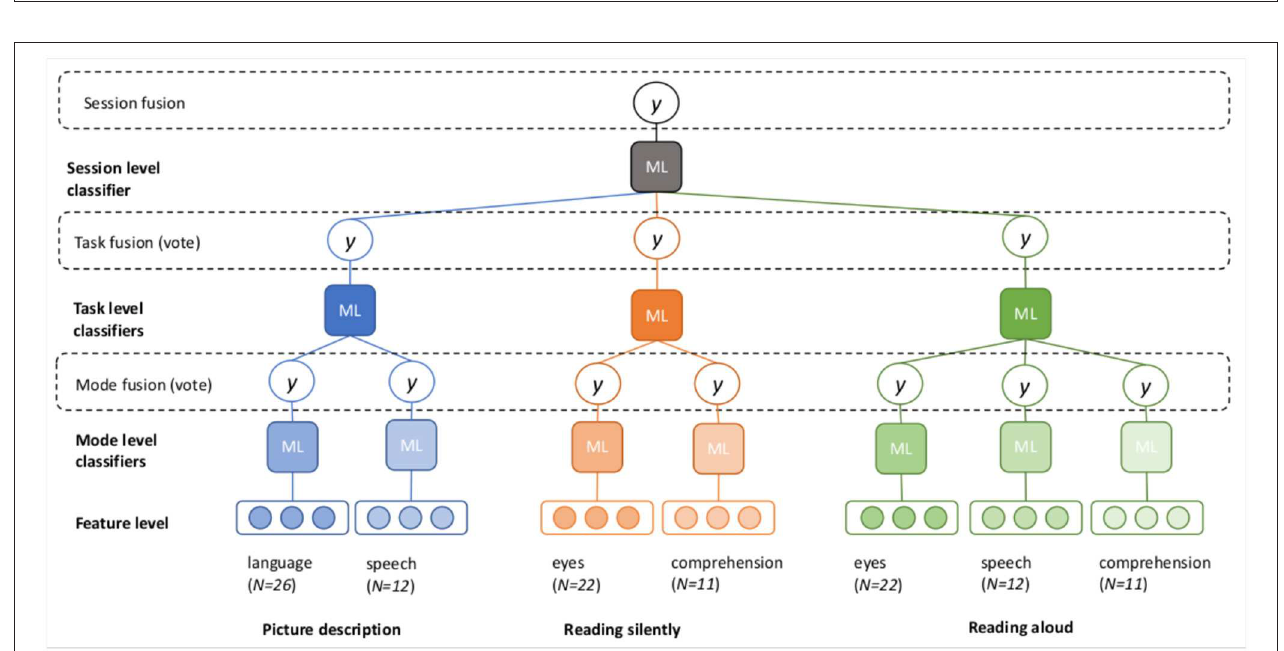
FIGURE 3 | Fusion at the mode, task, and session levels (late